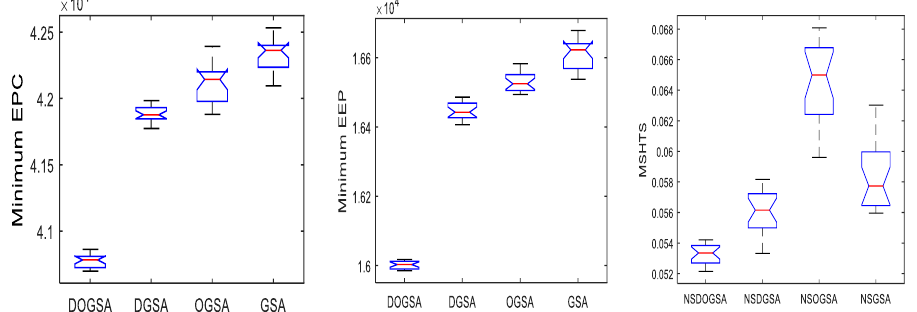
Figure 7. Box-type plots of Kruskal–Wallis test for Test System-I.